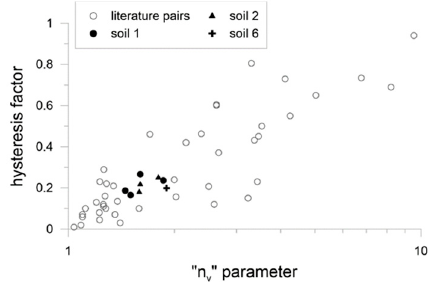
Figure 11. Hysteresis factor as a function of the parameter n v of the Van Genuchten model. Hollow circles represent data provided by literature datasets, and filled-in symbols were values calculated in the present investigation.